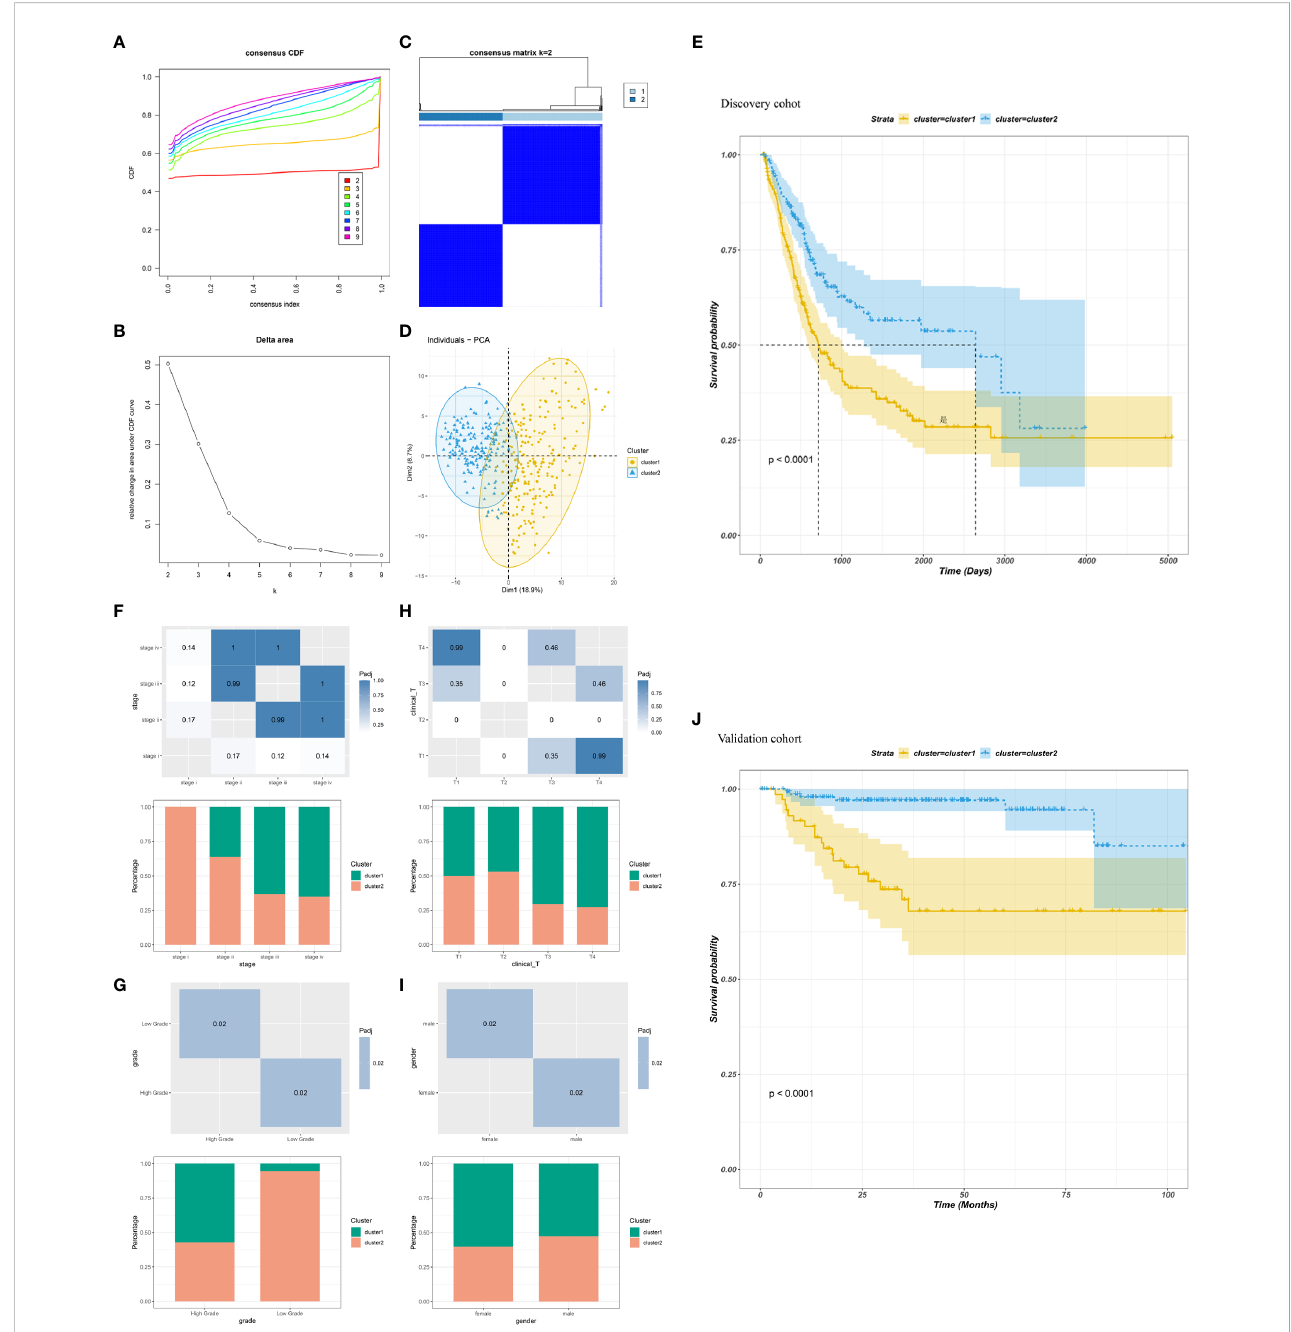
FIGURE 3 Identi fi cation of immune clusters of BLCA. (A) Cumulative distribution function curve and (B) delta area of immune-related genes in TCGA cohort. (C) Sample clustering heatmap. (D) Principal component analysis demonstrating two distinct clusters re fl ecting immune status. (E) Survival analysis of BLCA immune clusters in TCGA cohort. (F – I) Distribution of IC1 – 2 based on (F) stage, (G) grade, (H) clinical T stage and (I) sex in TCGA cohort. (J) Survival analysis of BLCA immune clusters in the GSE32894